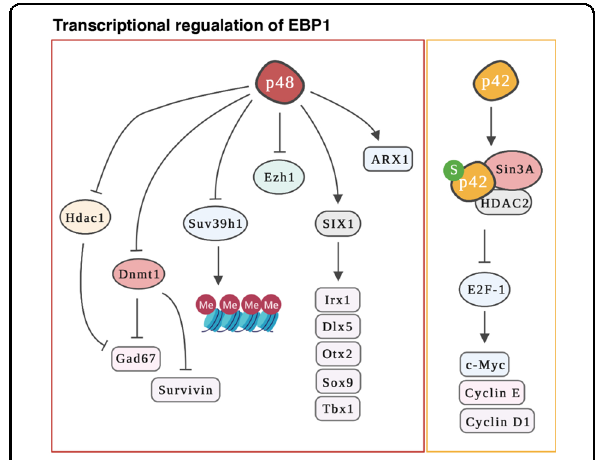
Fig. 5 Transcriptional regulation of EBP1. P48 represses the transcription of epigenetic regulators such as Hdac1, Dnmt1, Suv39H1, or Ezh1, whereas it enhances the transcriptional activity of SIX1 or ARX1. In particular, P48 directly binds to the promoter region of Dnmt1 or Hdac1 to inhibit their transcription as well as the expression of target genes, such as Survivin or Gad67, during brain development in mice. P42 interacts with the Sin3A/HDAC2 complex and suppresses the transcription of E2F-1-mediated genes such as c-Myc, Cyclin E, or Cyclin